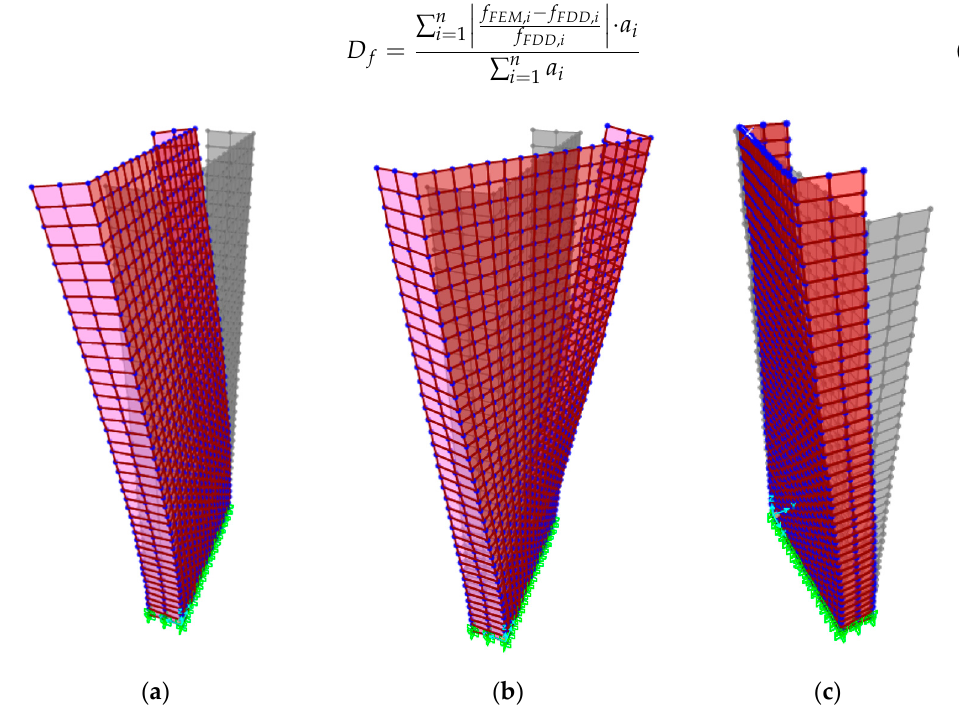
Figure 10. Numerical model shapes of the walls obtained experimentally: ( a ) first mode; ( b ) second mode; and ( c ) third mode.